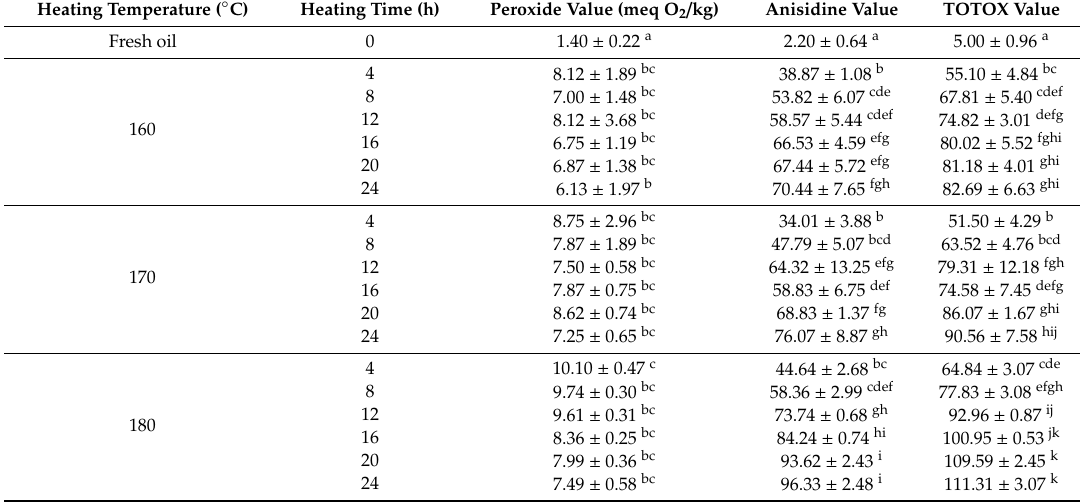
Table 3. Changes in the peroxide value, anisidine value and total oxidation (TOTOX) value in palm olein heated at di ff erent temperatures for di ff erent